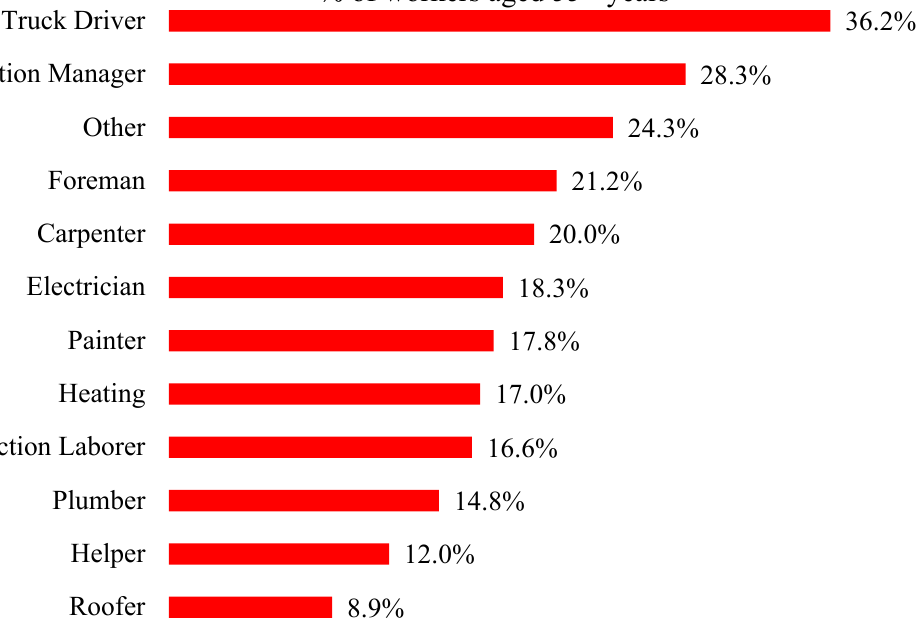
Figure 3. Percentage of construction workers aged 55+ years, selected construction occupations, 2017 (All employment). The proportion of workers age 55 and older increased in all occupations, including roofers and laborers, between 2003 and 2017 (see Figure 4).